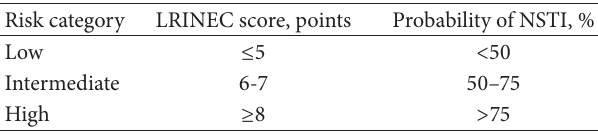
Table 2: Risk stratification of the LRINEC score according to the likelihood of necrotizing soft tissue infection (NSTI)